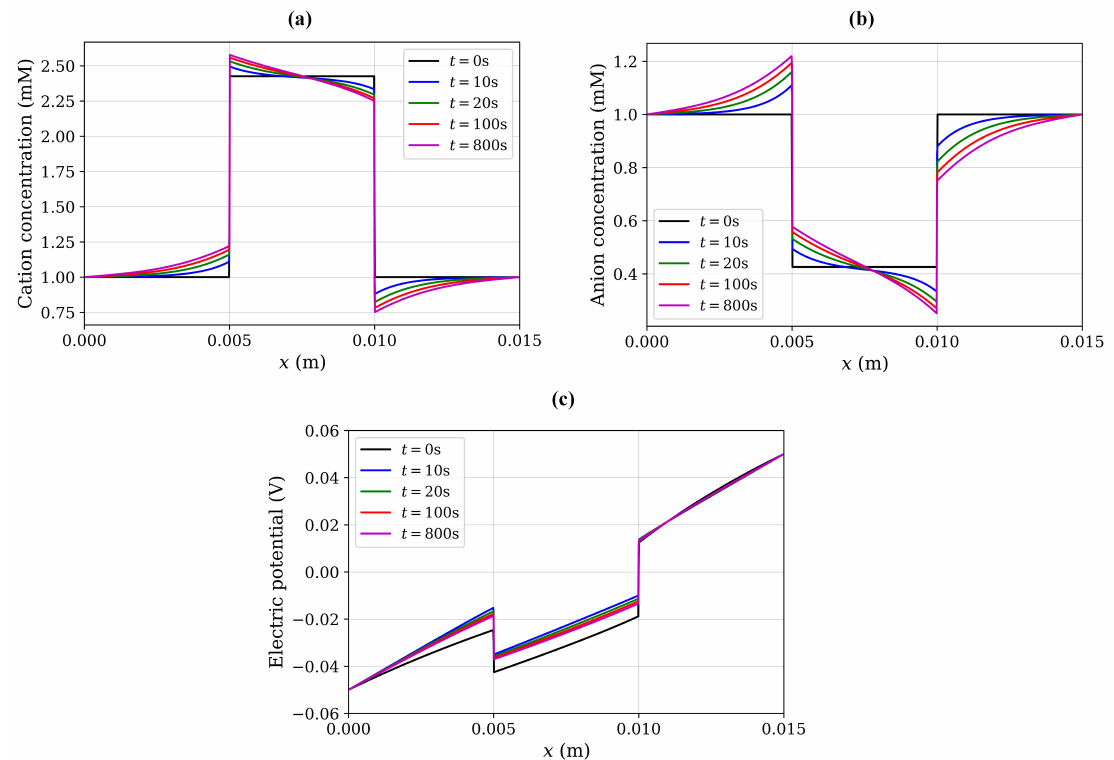
Figure 10. Transient variation of quantities for a hydrogel scaffold immersed in solution: ( a ) cation concentration, ( b ) anion concentration, ( c ) electric